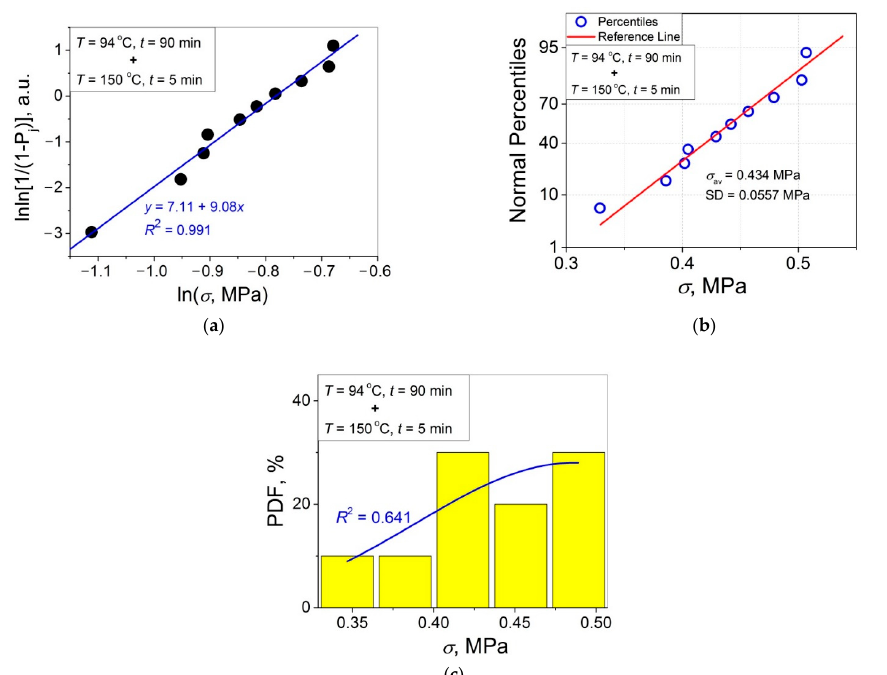
Figure 8. ( a ) Linear regression fit of the lap shear strength σ in Weibull’s coordinates; ( b ) normal probability plot; ( c ) probability density function (PDF) vs. σ fitted with a Gaussian function for an amorphous PET–PET interface self-bonded at T = 94 °C for t = 90 min and at T = 150 °C for t = 5 min.